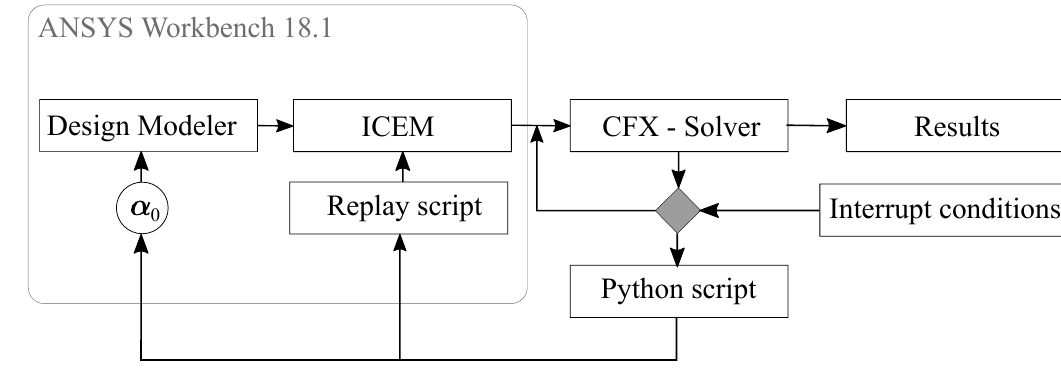
Figure 3. Remeshing procedure.